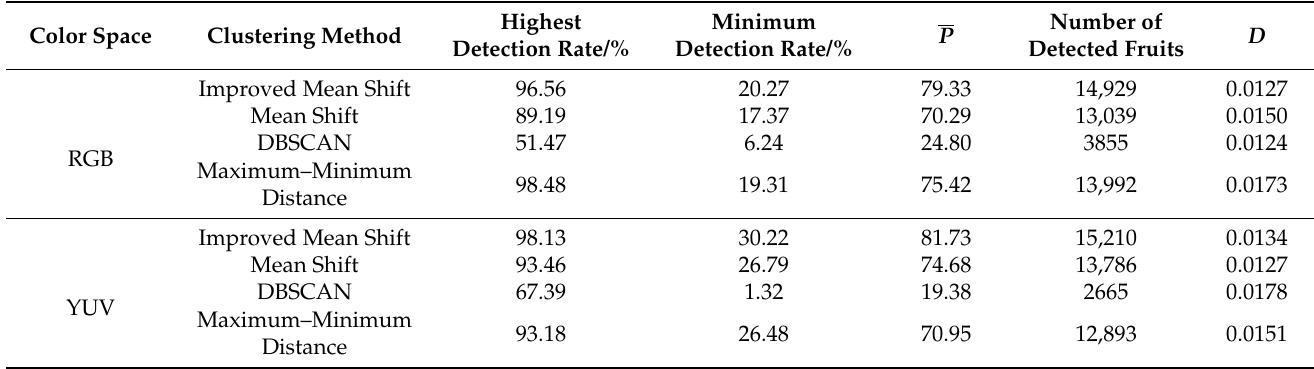
Table 3. Comparison of the results for the clustering methods in the RGB and YUV color